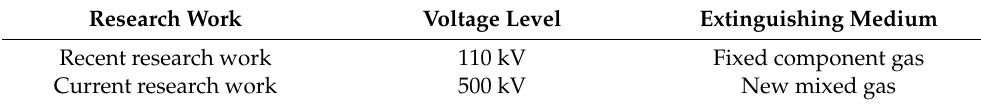
Table 9. Benchmark table to summarize a recent research work as compared to the current